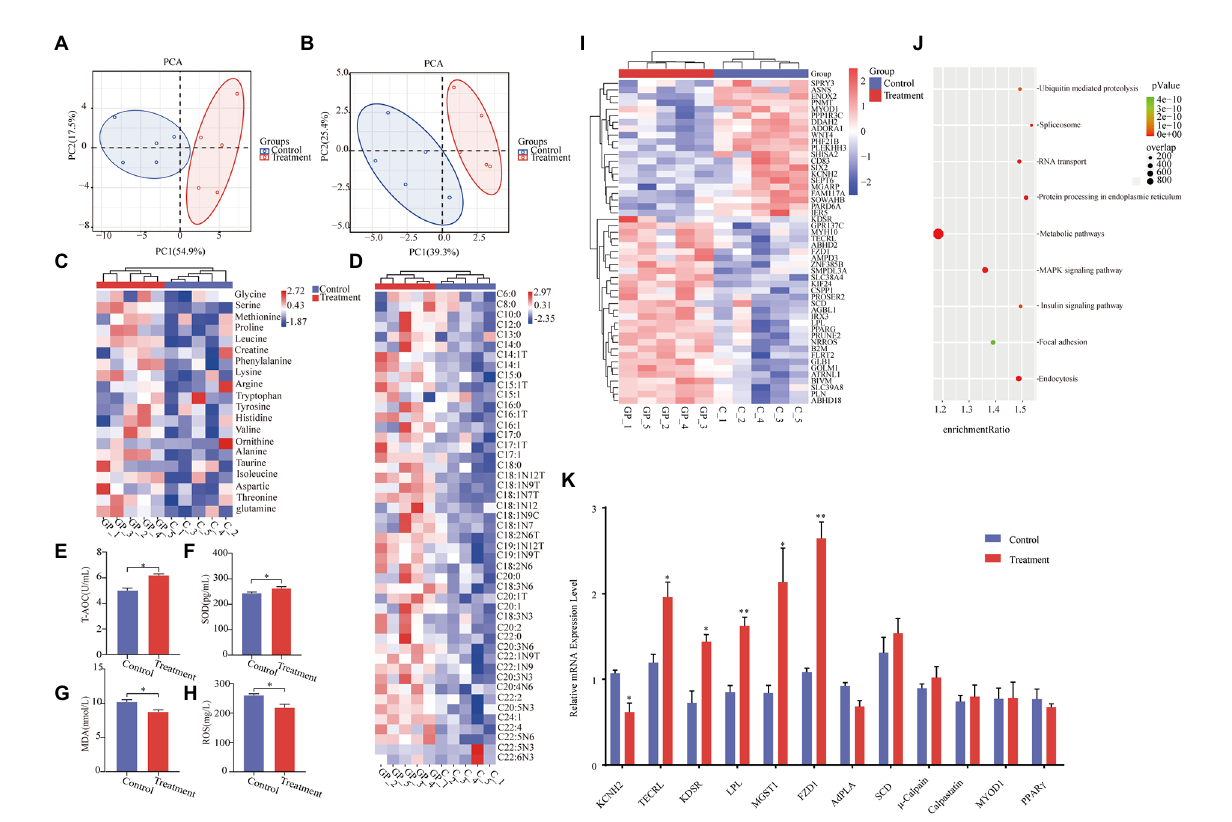
FIGURE 1 Effect of grape pomace diet on the meat quality. (A) Principal component analysis ordination plots of amino acid in the control and treatment group based on the Bray–Curtis distance metric. (B) Principal component analysis ordination plots of fatty acid in the control and treatment groups based on the Bray–Curtis distance metric. (C) Heatmap of amino acid in the control and treatment groups. (D) Heatmap of fatty acid in the control and treatment groups. Meat levels of indicators including (E) T-AOC, (F) SOD, (G) MDA, and (H) ROS were determined by using respective kits. Control group, a basal diet; treatment group, a basal diet’s wheat bran is replaced with grape pomace. Data were shown as means ± SD ( n = 5), * refers to a significant difference ( p < 0.05). T-AOC, total antioxidant capacity; SOD, superoxide dismutase; MDA, malondialdehyde; and ROS, reactive oxygen species. (I) Heatmap of transcripts in the control and treatment groups. (J) Gene enrichment analyses of the significantly changed pathways. (K) RT- qPCR analysis of KCNH2, TECRL, KDSR, LPL, MGST1, FZD1, AdPLA, Scd, μ -Calpain, Calpastatin, MYOD1, and PPAR γ in LT from the control group and treatment group. * p < 0.05, ** p <